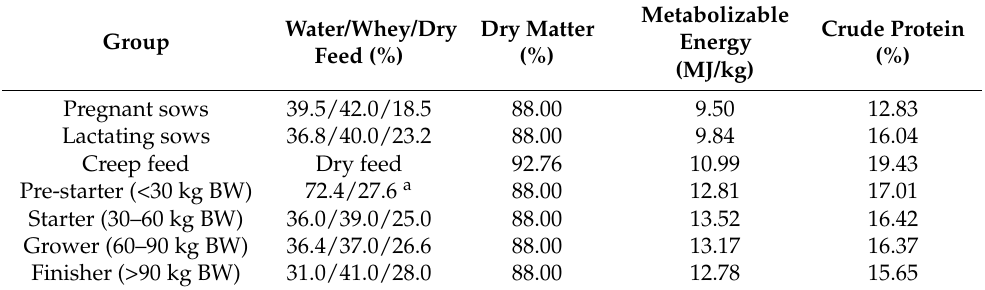
Table 1. Feeding protocol of pregnant and lactating sows and their